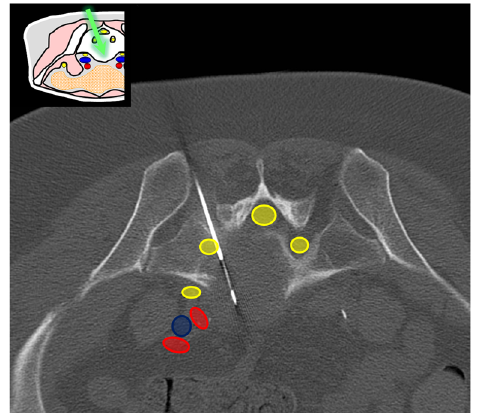
Fig. 7 A 64-year-old woman presenting with a sacral lytic lesion extending into the first and second sacral foramina. A posterolateral approach through the S1 foramen was chosen to allow the use of a coaxial 16-G cutting needle. Biopsy proved it to bea poorly